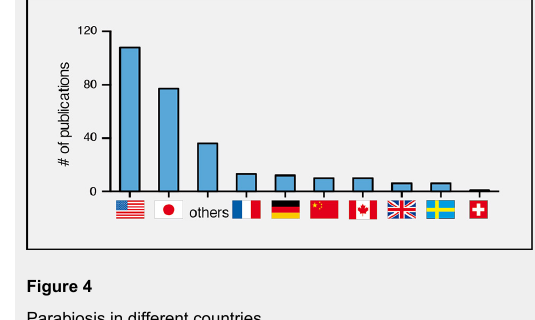
Parabiosis in different countries. Publications including parabiosis experiments are listed for different countries. All values have been extracted from